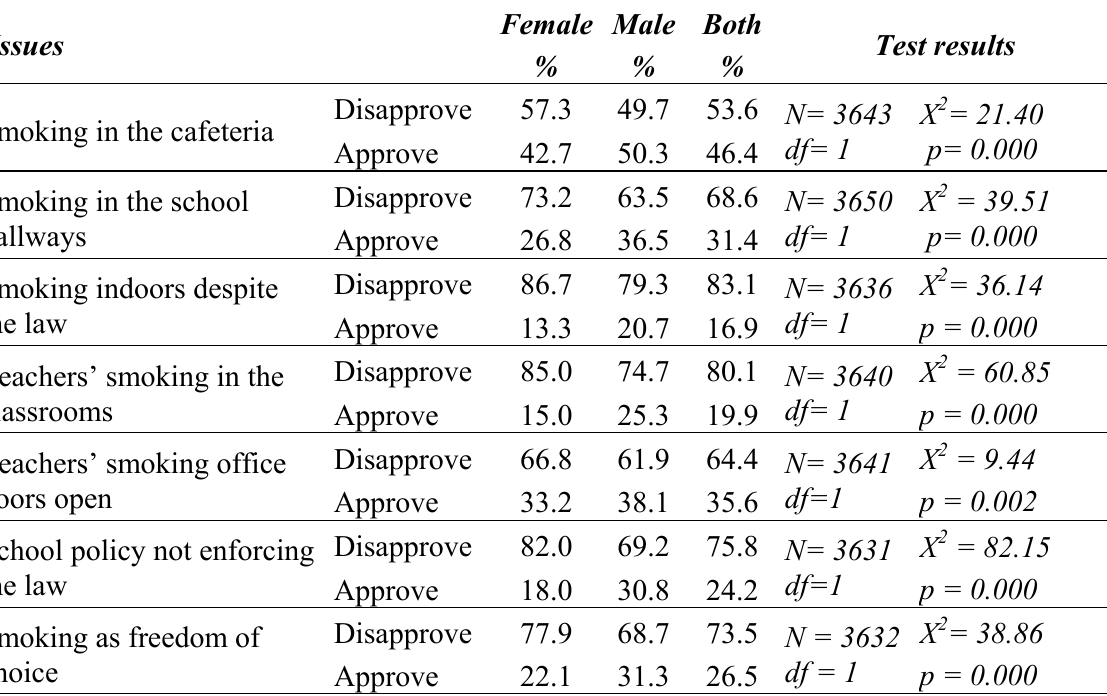
Table 1. Distribution of responses by